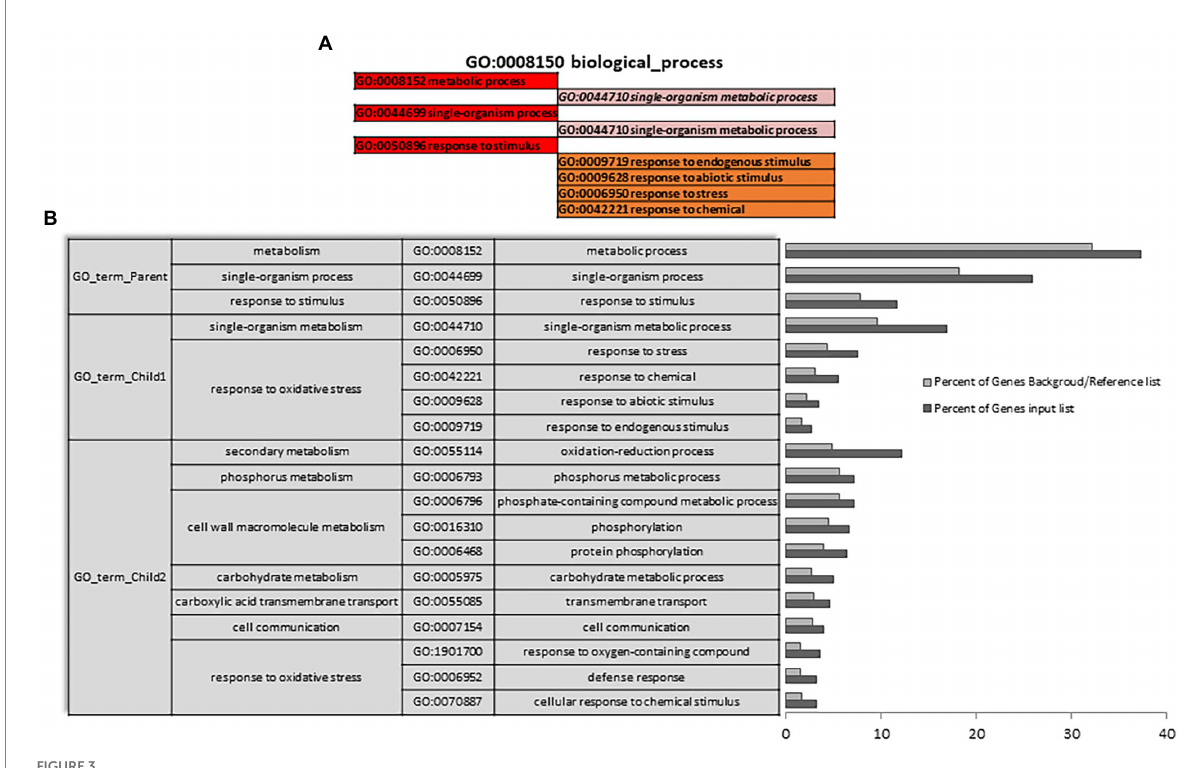
FIGURE 3 Total gene ontology enrichment. DEGs obtained between after harvest (AH) and non-cold stored (NCS). A Singular Enrichment Analysis (SEA; FDR ≤ 0.05) showing the GO for the most significant biological processes categories obtained comparing AH vs. NCS. (A) Scheme of the total enrichment (TE). (B) Bar chart of overrepresented terms in biological process category. The Y -axis shows the definition of each of the processes included in the first three GO terms annotated. The X -axis is the percentage of genes mapped by the term, and represents the abundance of the GO term. The percentage for the input list is calculated by the number of genes mapped to the GO term divided by the number of all genes in the input list. The same calculation was applied to the reference list to generate its